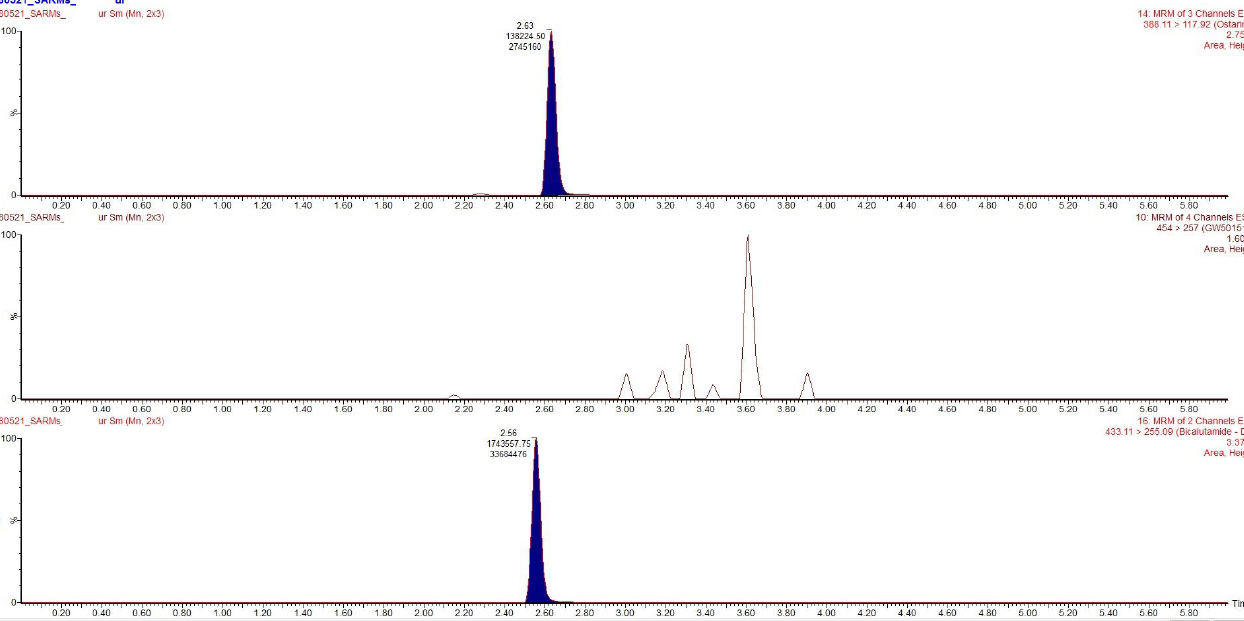
Figure 3. Chromatogram obtained after extraction of the urine. From top to bottom: ostarine (88 ng/mL), cardarine (not detected) and the internal standard.